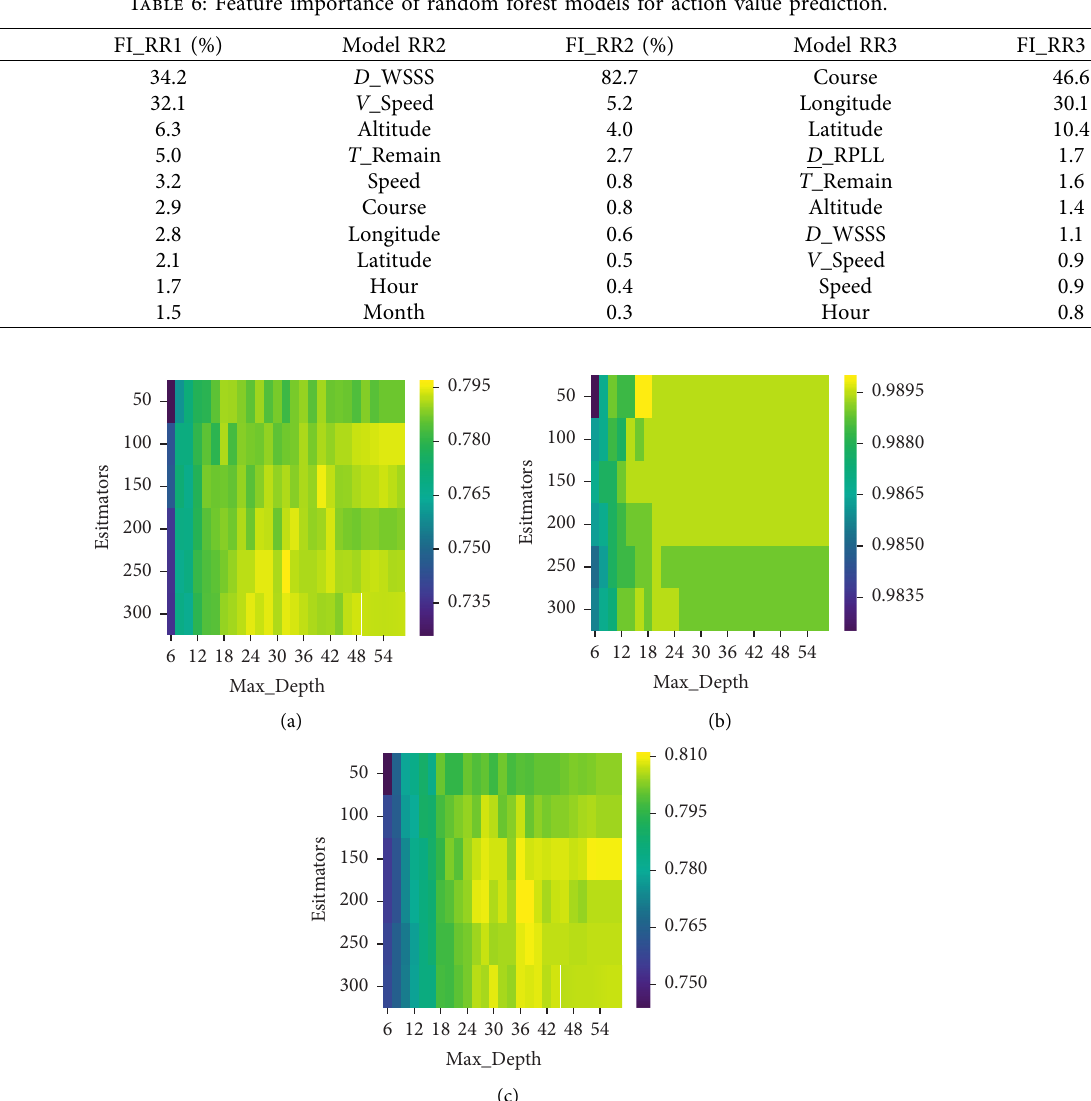
Figure 16: Illustration for parameter tuning process for classification models. Estimators are [50: 300, step 50] and Max_Depth are [6 : 58, step 2]. (a) Speed action, (b) vertical action, and (c) course